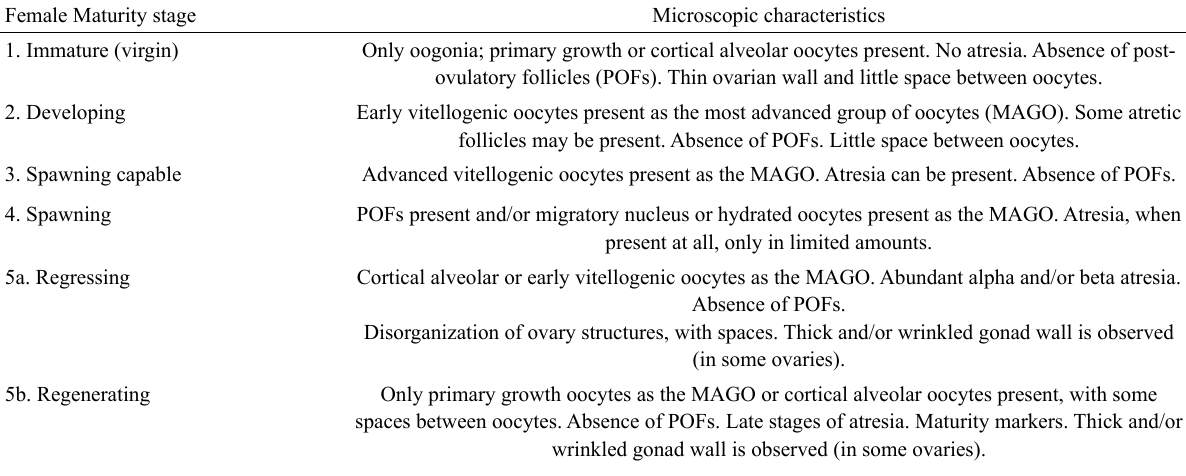
Table 1. – Microscopic classification criteria for females based on a modification of Schaefer (1998), Farley et al. (2013) and Saber et al. (2015). Female Maturity stage